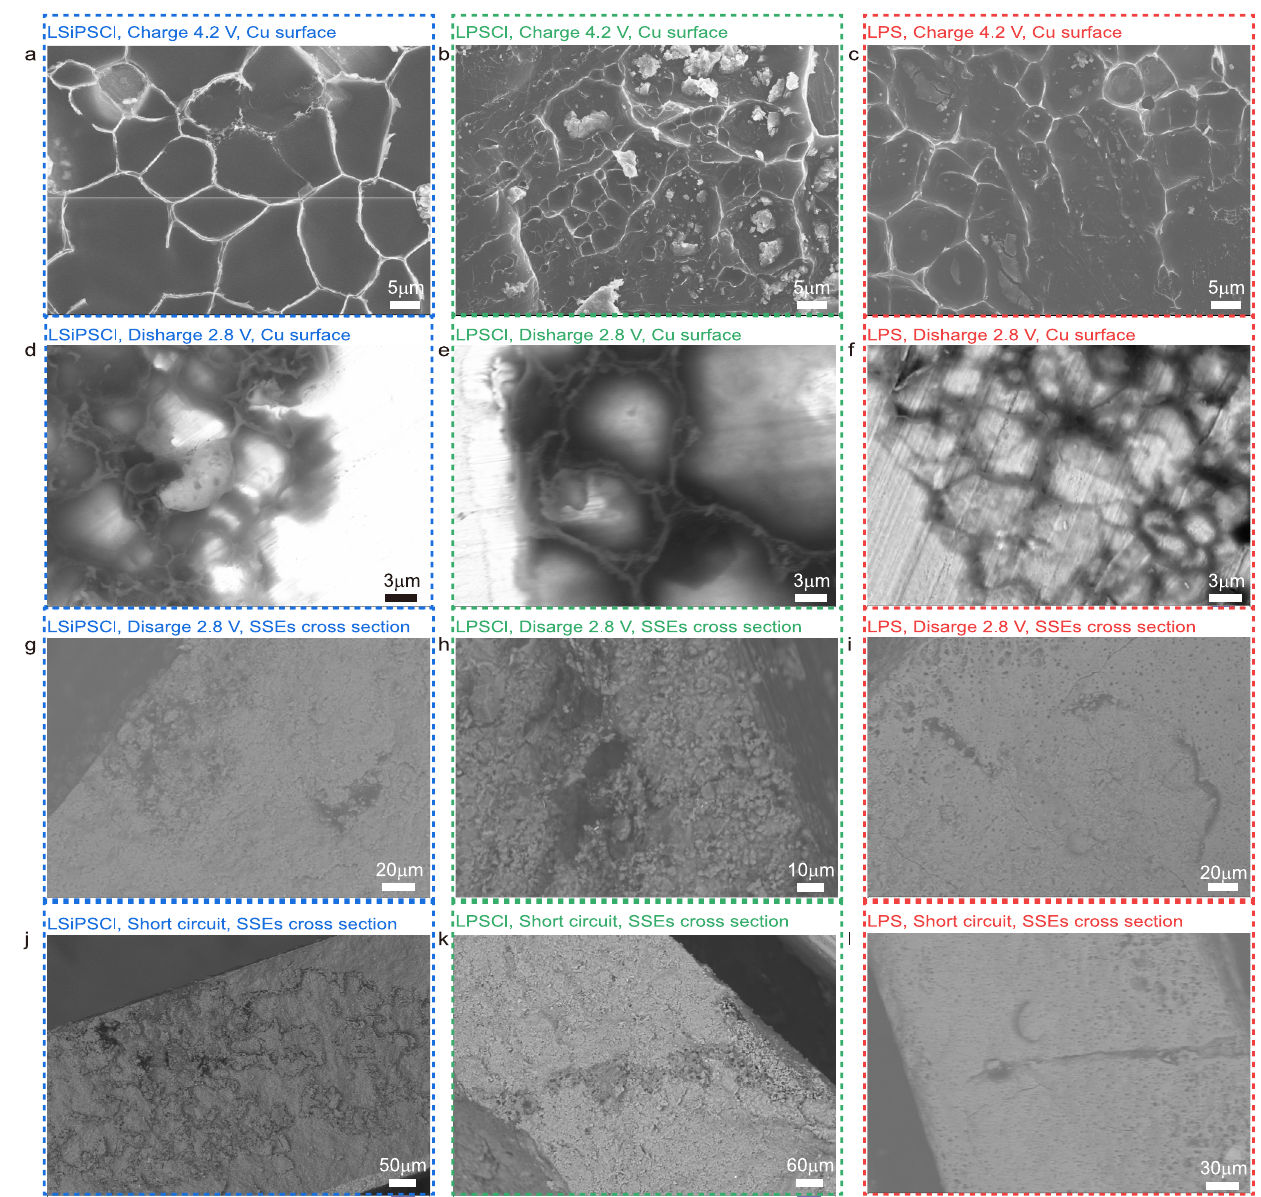
Fig. 2 | Morphological evolution of the Li metal deposited on the Cu and the cross-section of the representative SSEs. a – c SEM images of the Cu disc surface afterchargingto4.2Vinthe fi rstcycle( a – c ). d – l SEMimagesoftheCudiscsurface ( d – f ) and SSEs cross-section ( g – l ) using the backscattered electron (BSE) mode,